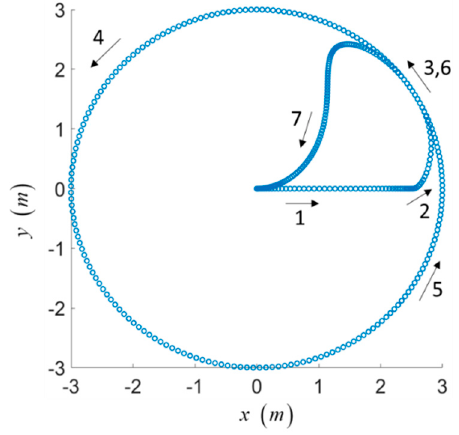
Appl. Sci. 2020 , 10 , x FOR PEER REVIEW Figure 18. The trajectory of moving platform for simulation test. Figure 18. The trajectory of moving platform for simulation test.